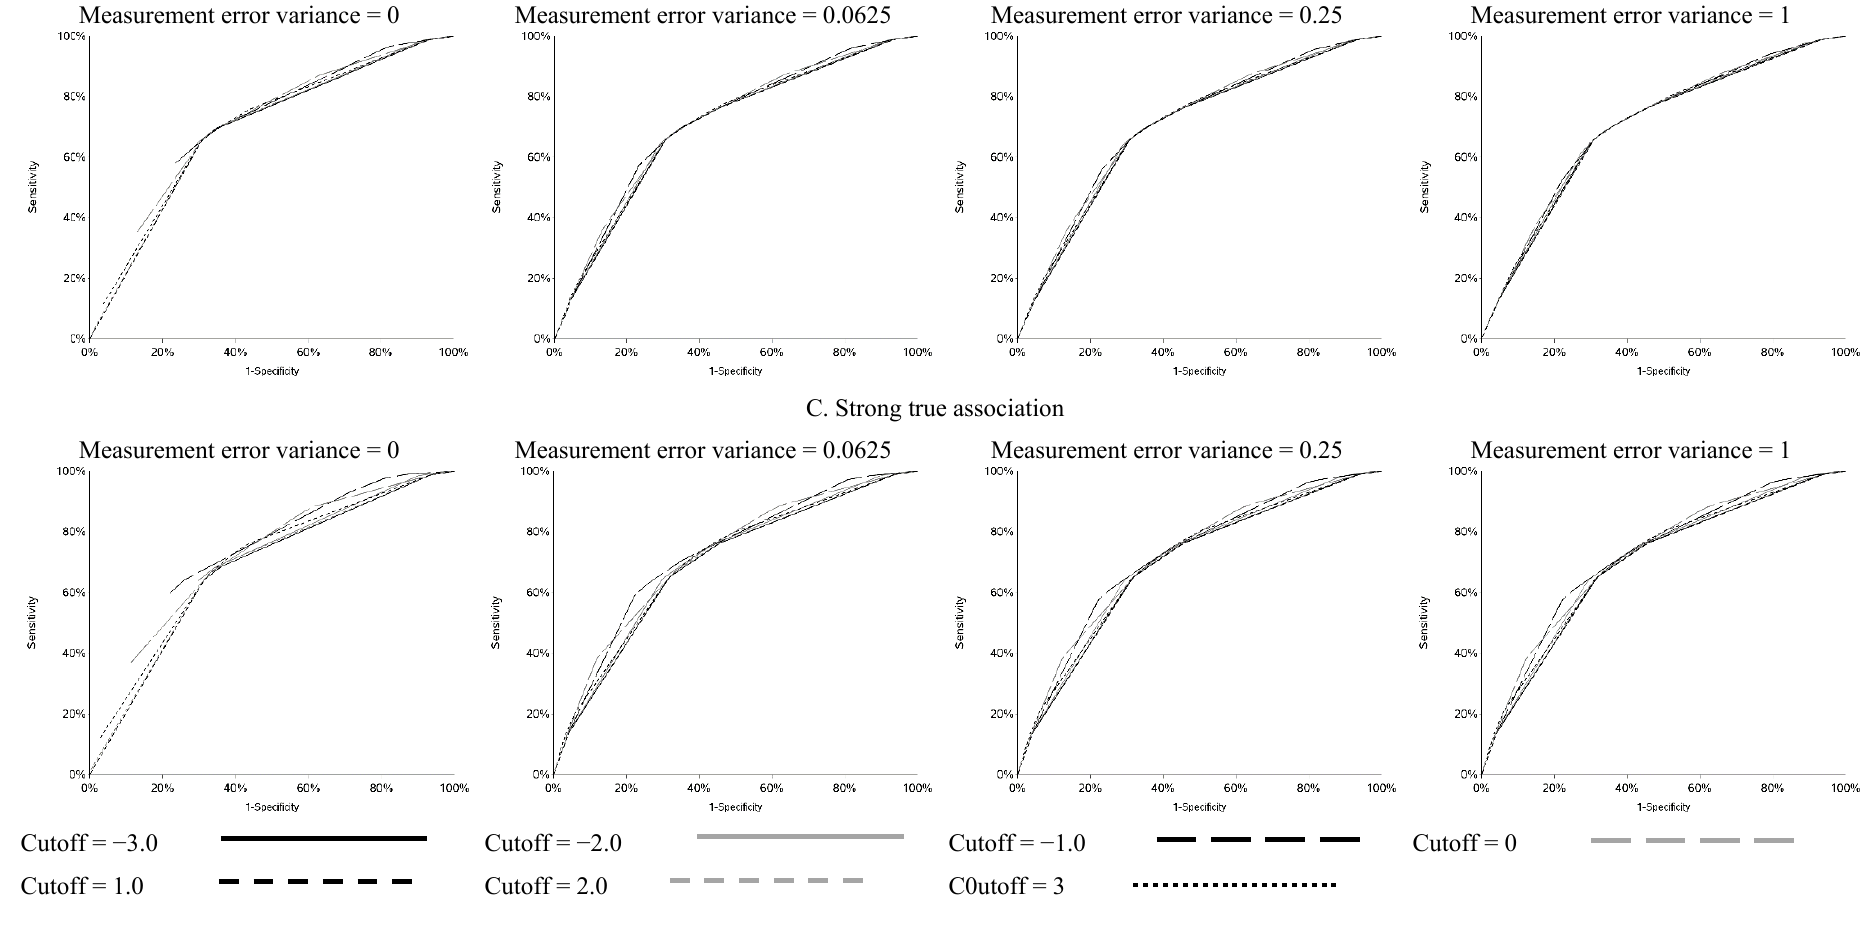
Figure A5. ROC curves for selected cutoffs for W 1